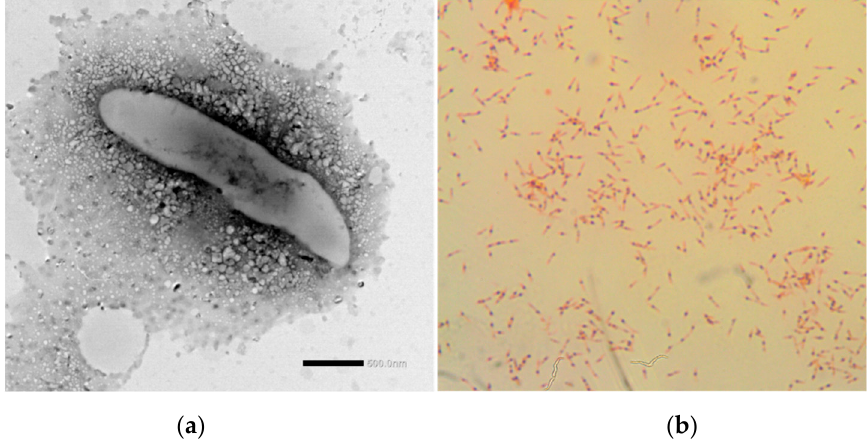
Figure 2. Anianabacter salinae ASV31 T cell characteristics observed using microscopy: ( a ) Transmission electron micrograph of a cell. A polysaccharide mucous capsule was observed around the cell and darker spots in the cytoplasm. Bar 500.0 nm. ( b ) Sudan black B staining of PHA granules observed as black intracellular granules under 100× oil immersion objective.